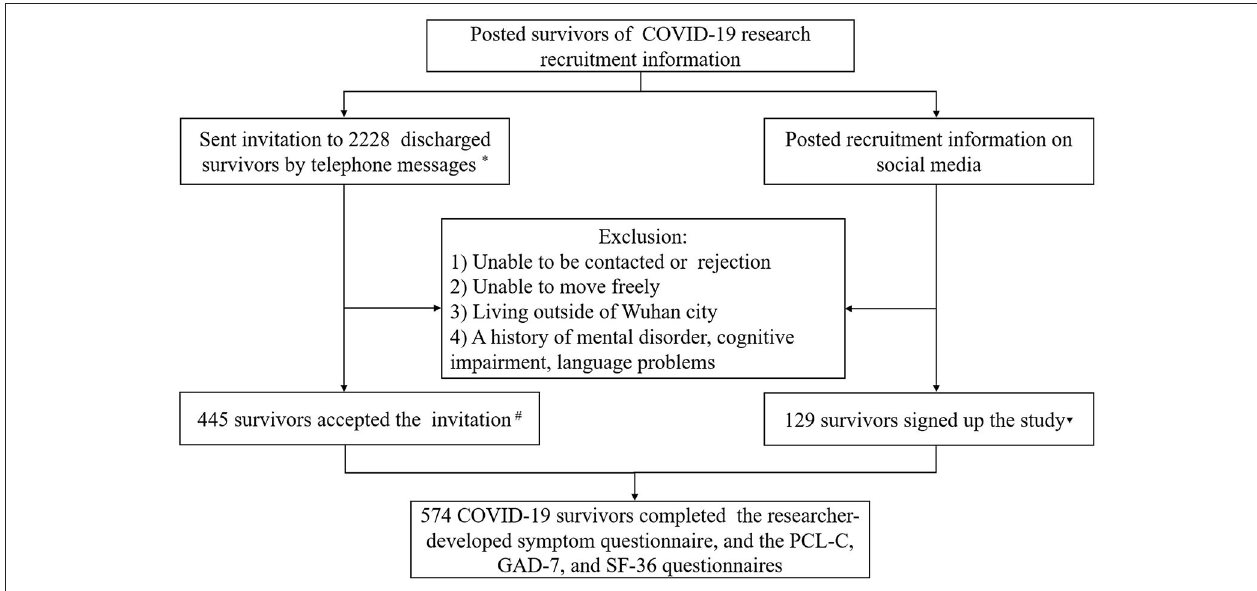
FIGURE 1 | Flow chart of COVID-19 survivor recruitment. *The breakdown of survivors is as follows: from Hubei Provincial Hospital of Traditional Chinese and Western Medicine ( N = 682), Wuhan’s Leishenshan Hospital ( N = 1,014), and Wuhan’s Hankou Hospital ( N = 532). # The breakdown of survivors is as follows: from Hubei Provincial Hospital of Traditional Chinese and Western Medicine ( N = 197), Wuhan’s Leishenshan Hospital ( N = 165), and Wuhan’s Hankou Hospital ( N = 83). H The breakdown of survivors is as follows: from Wuhan’s Huoshenshan Hospital ( N = 70), Wuhan Jinyintan Hospital ( N = 6), Taikang Tongji (Wuhan) Hospital ( N = 12), Wuhan Asia Heart Hospital ( N = 5), Wuhan No. 1 Hospital ( N = 4), Wuhan No. 3 Hospital ( N = 3), Wuhan No. 4 Hospital ( N = 3), Wuhan No. 9 Hospital ( N = 3), Renmin Hospital of Wuhan University ( N = 3), Wuhan Wuchang Hospital ( N = 2), Central Hospital of Wuhan ( N = 2), Wuhan Hanyang Mobile Cabin Hospital ( N =